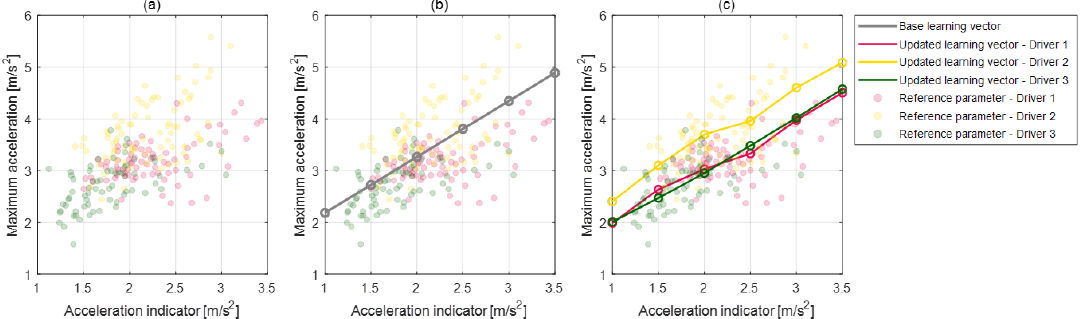
Figure 11. Maximum acceleration parameter and its updated vector array by the learning algorithm.